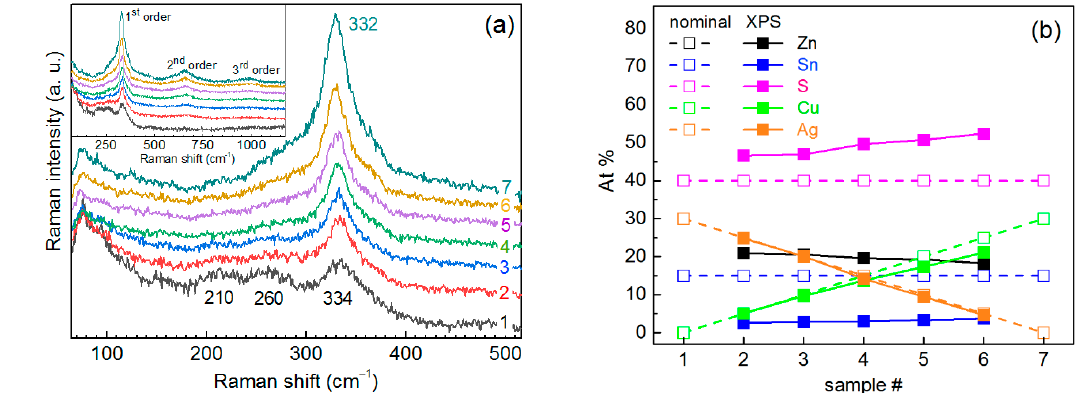
Figure 1. ( a ) Raman spectra of the Ag x Cu 1 − x ZnSnS 4 (ACZTS) NC series ( λ exc = 514.7 nm), with the elemental composition of the same samples 1–7 given in ( b ). The inset shows spectra covering the range of 2nd and 3rd overtones of the main peak. ( b ) Nominal (empty symbols, dashed lines) and measured by XPS (solid lines, filled symbols) elemental compositions of the ACZTS NC series.